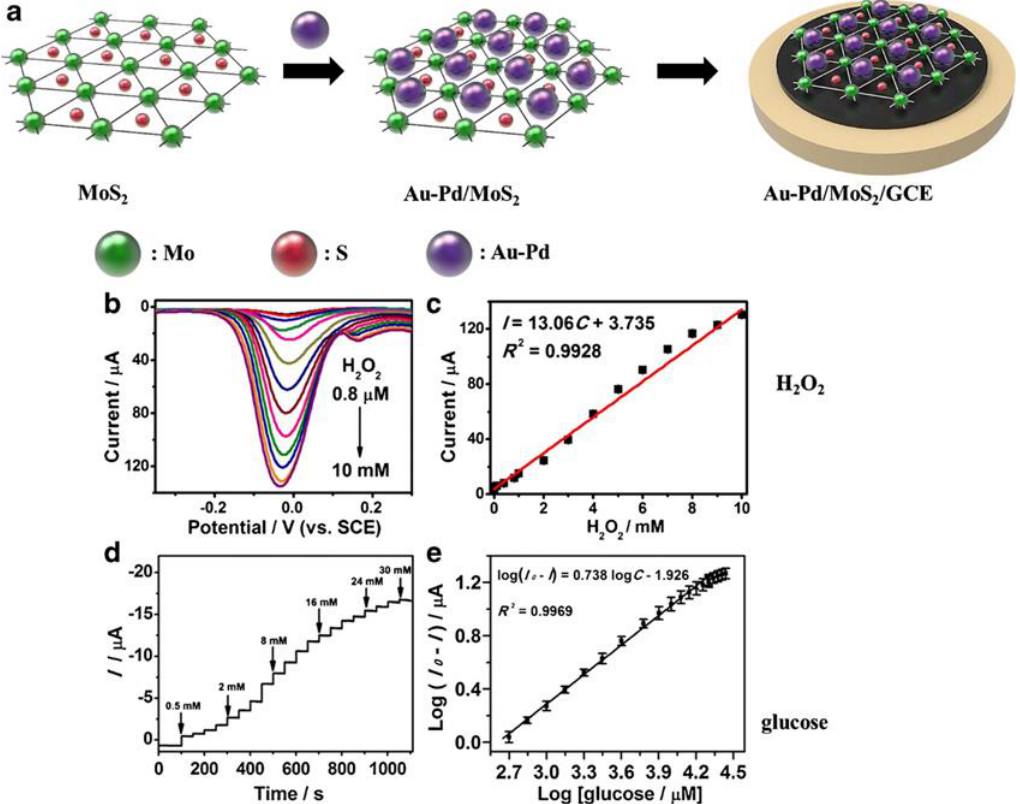
Figure 7. ( a ) Schematic representations of Au-Pd / MoS 2 / GCE sensor. ( b ) Differential pulse voltammetry (DPV) curves for different H 2 O 2 concentrations. ( c ) DPV peak current as a function of H 2 O 2 concentration. ( d ) Amperometric responses for different glucose concentrations. ( e ) Plot of amperometric response vs. the logarithm of glucose concentration. Reprinted with permission from reference [60].